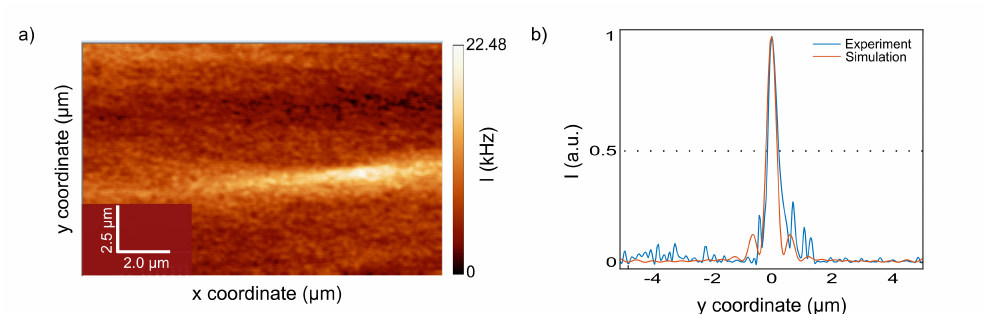
Figure 7. Experimental results were obtained with an NSOM scan of a 10 µ m diameter Silica microcylinder illuminated by a 637 nm continuous plane wave in the x -direction. ( a ) Scanned image in photon counts units using the photodiode. ( b ) The normalized intensity distribution was extracted from the NSOM image (blue) compared to the calculated intensity (orange) for the simulated 10 µ m diameter Silica microcylinder. The dashed black line indicates the FWHM.